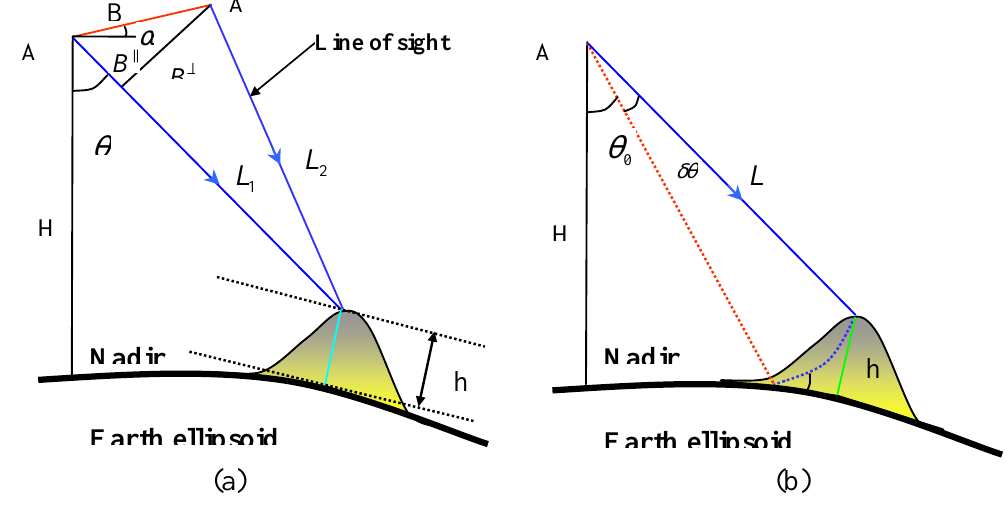
Figure 1. Interferometric geometry (from Li et al .